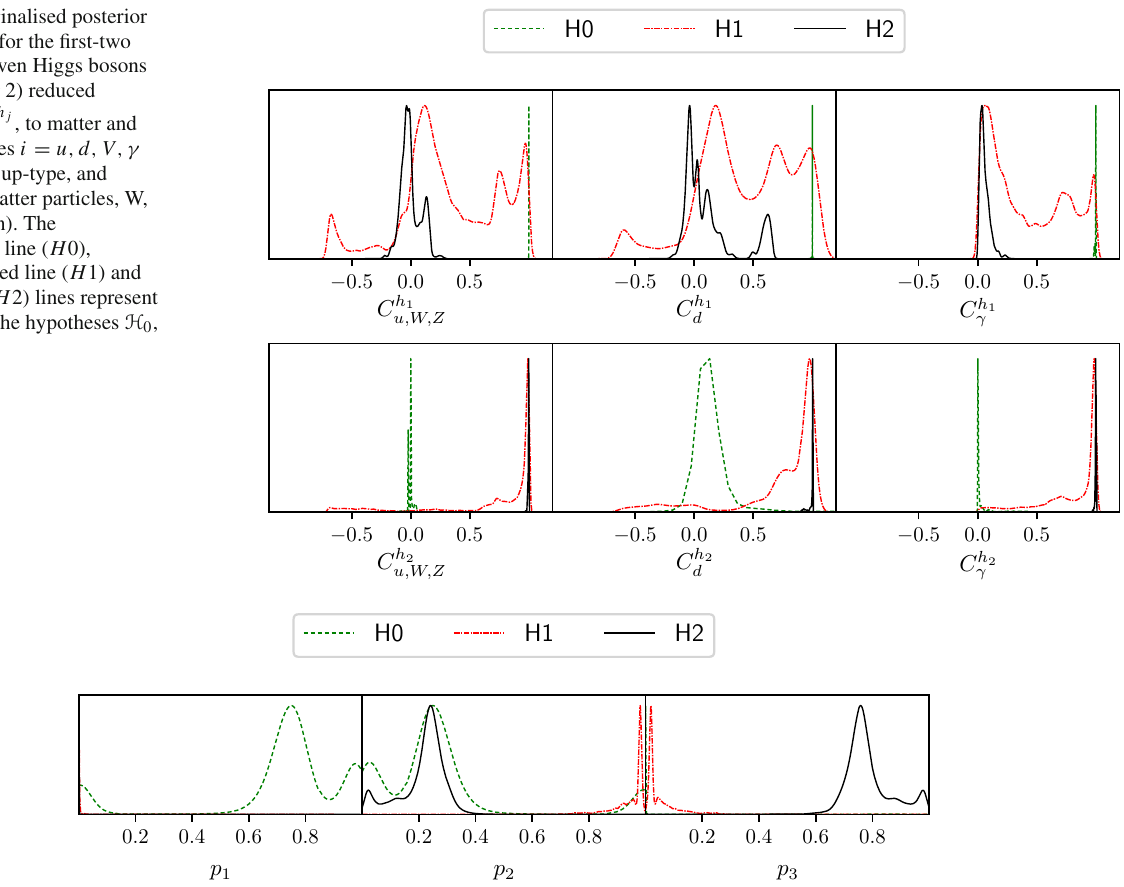
Fig. 3 MarginalisedposteriordistributionsfortheneutralinoLSPcon- dashed/green ( H 0), dash-dotted/red ( H 1) and solid/black ( H 2) lines + N 2 + N 2 tent. Here p 1 = N 2 represent the hypotheses H 0 , H 1 and H 2 , p 2 = N 2 , and p 3 = N 2 quan- 11 12 13 14 15 tifies the gaugino, Higgsino, and singlino content of the LSP. The